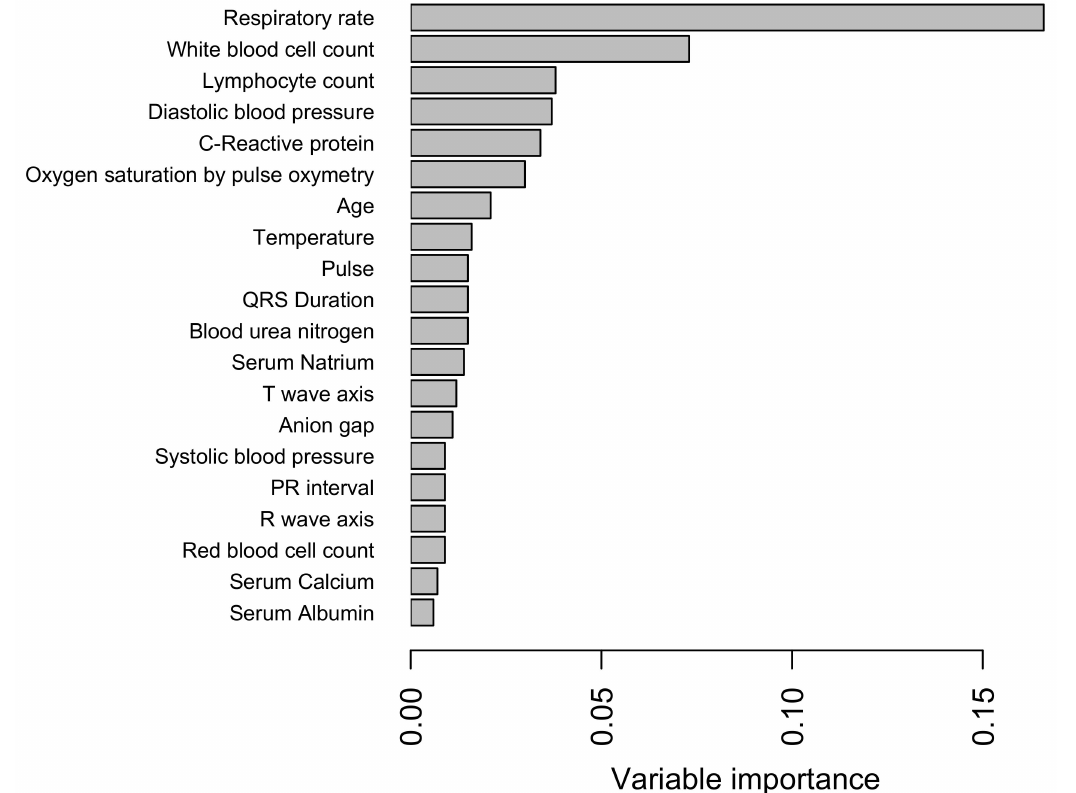
Figure 2. Gini importance: top 20 predictive